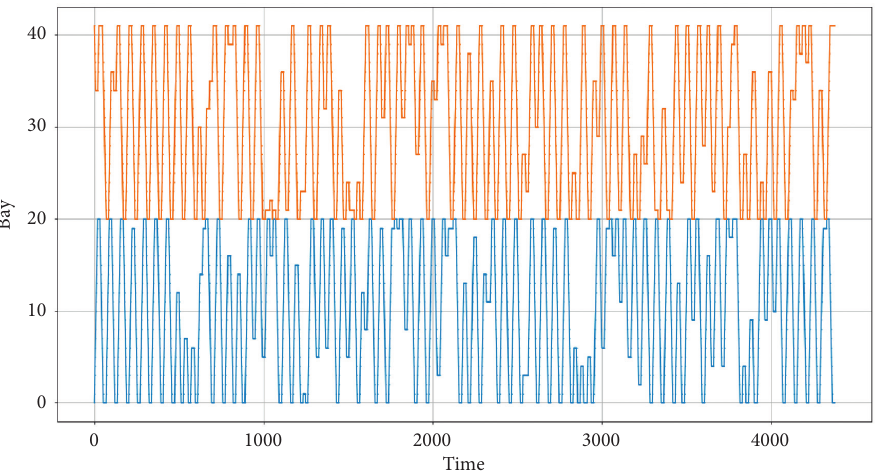
Figure 12: Tracks of the twin ASCs of setting the handshake area. Table 3: Comparisons among (M) and